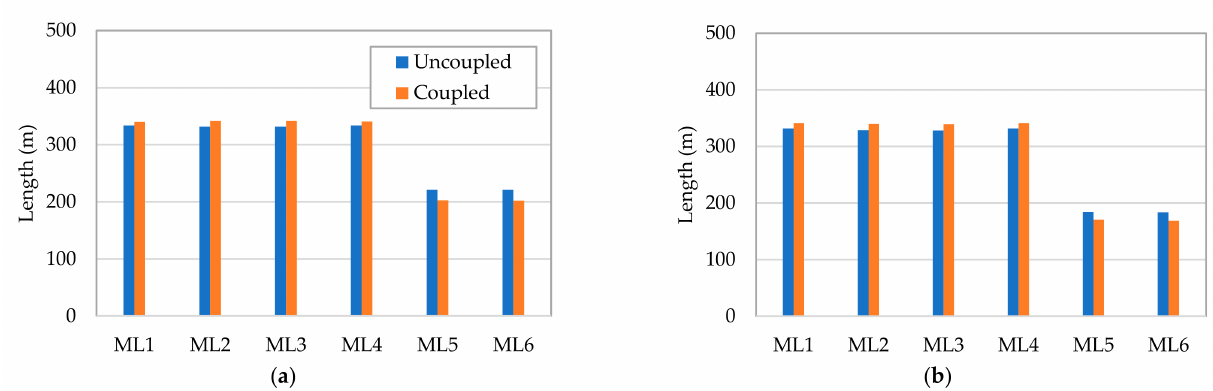
Figure 16. Anchor line length on seabed of the mooring buoy under storm seas: ( a ) 50 y; ( b ) 100 y. Figure 17 compares the mooring line Touch-Down Point (TDP) footprints for the uncoupled and coupled cases under the 50 y and heading 0 deg. condition. Among the anchor lines, slack line ML2 and taut line ML5 are considered. For comparisons, the initial static locations on the seabed from the static TDP to the anchor point are also presented. The static TDPs of the ML2 and ML5 are located around (+60, +90) m and ( − 110, − 10) m in the global X and Y directions, respectively.